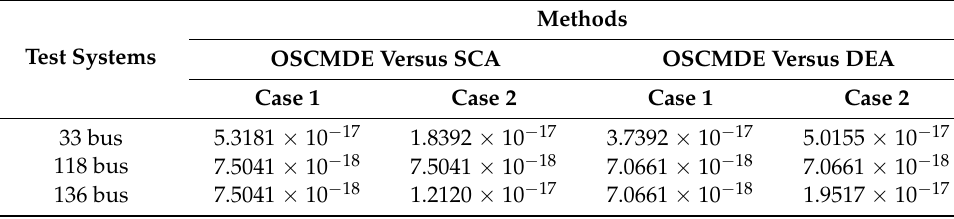
Table 18. Wilcoxon signed-rank test for scenario I applied to the different test systems.